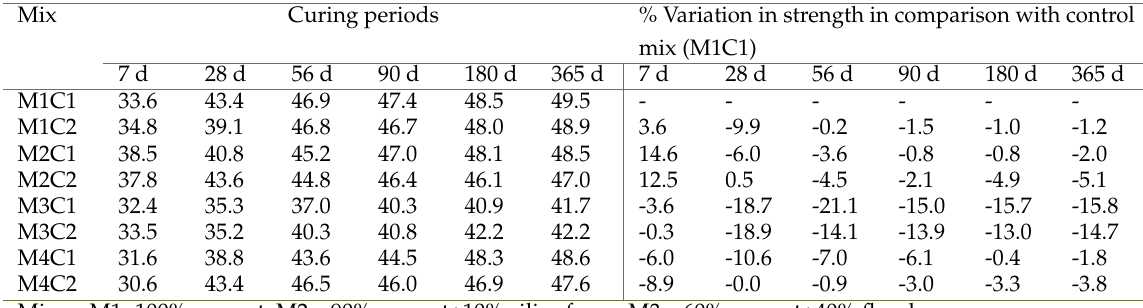
Table 3. Compressive strength of concrete in MPa for different curing periods Mix Curing periods % Variation in strength in comparison with control mix